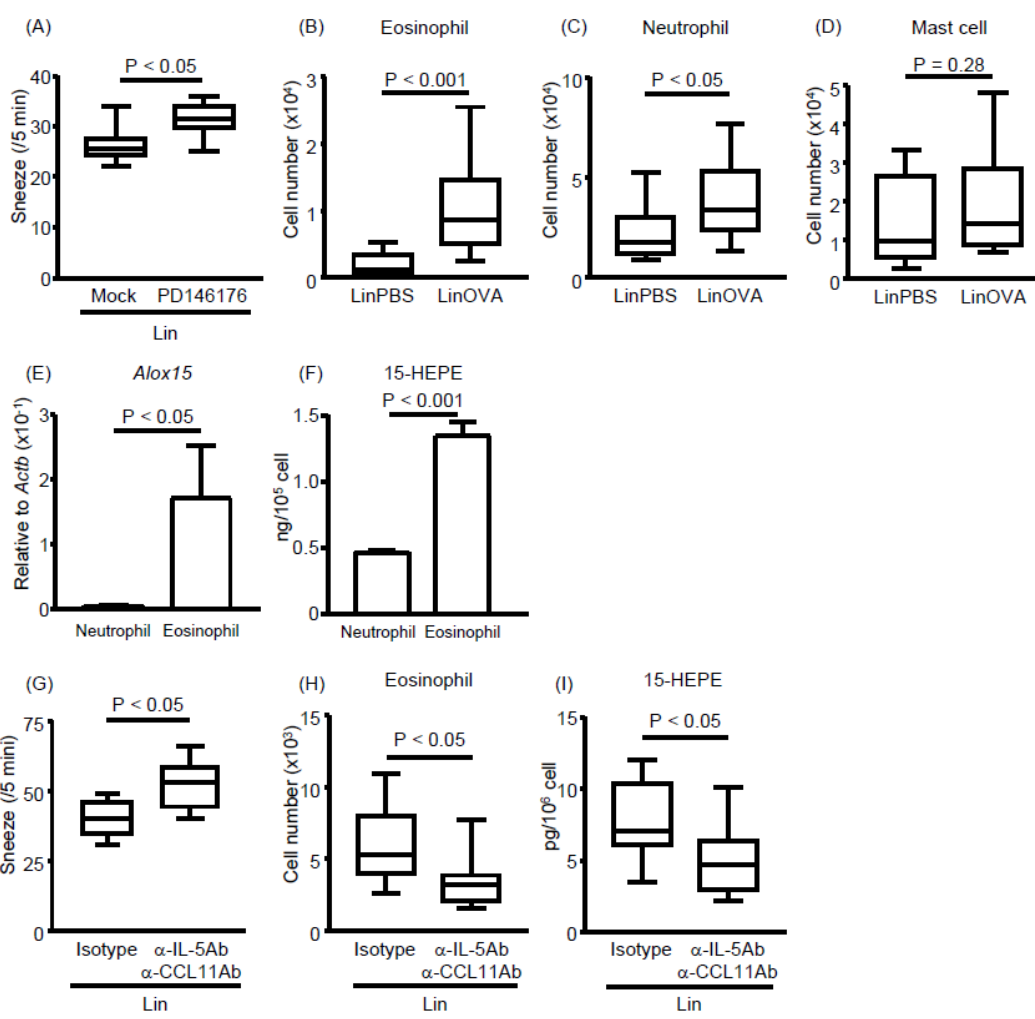
Figure 5. Eosinophils infiltrate the nasal passages upon the development of allergic rhinitis and produce 15-HEPE and eosinophil inhibition aggravates allergic rhinitis in linseed oil-fed mice. ( A ) PD146176, an inhibitor of 15-LOX, was injected into mice fed a linseed oil diet, and sneezing rates were calculated after the induction of allergic rhinitis. Data are from two independent experiments ( n = 8). Center values indicate medians. Statistical significance was calculated by using the Mann–Whitney U test. ( B–D ) After the induction of allergic rhinitis, the numbers of ( B ) eosinophils, ( C ) neutrophils, and ( D ) mast cells in the nasal passage were calculated based on the total cell number and Flow cytometry data. Data are from three independent experiments ( n = 9 or 10). Center values indicate medians. Statistical significance was calculated by using the Mann–Whitney U test. ( E )